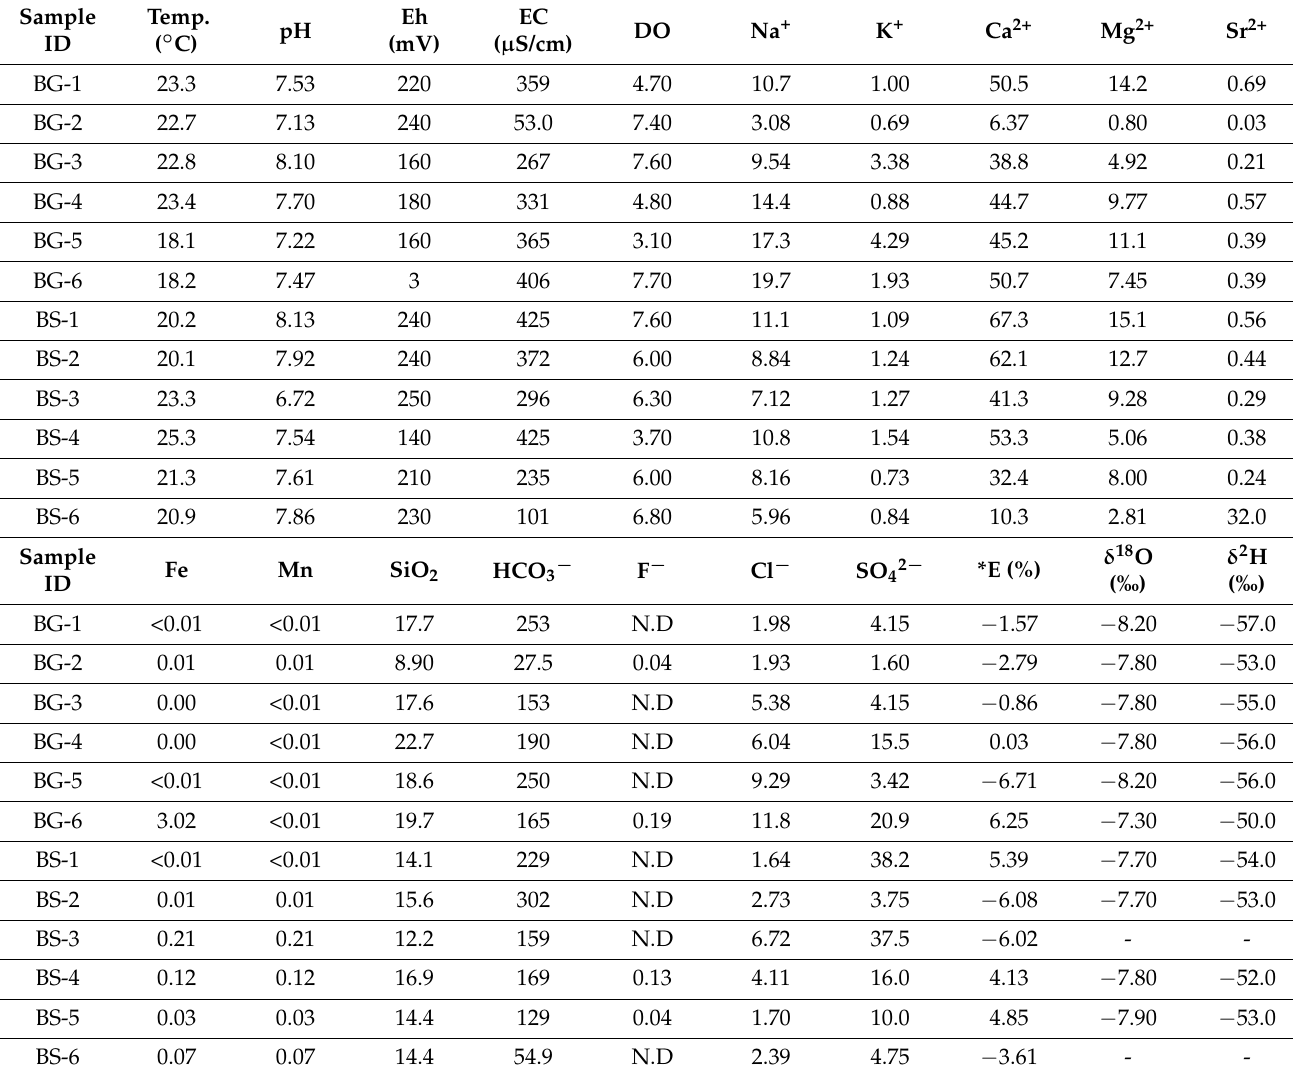
Table 2. Geochemical and isotopic composition of groundwater and stream water samples (mg/L) from the study